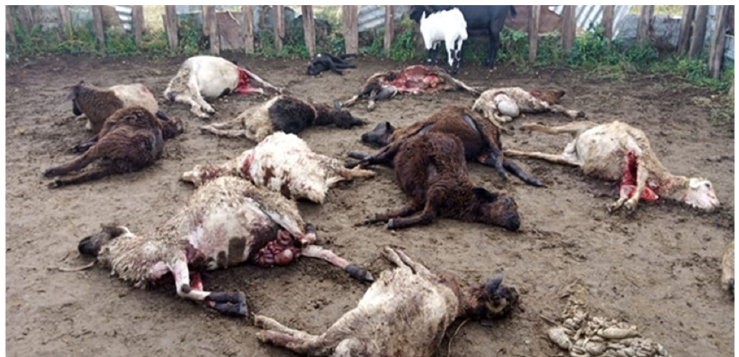
FigureA4: Sheep Killed by Hyena in Mara Siana.